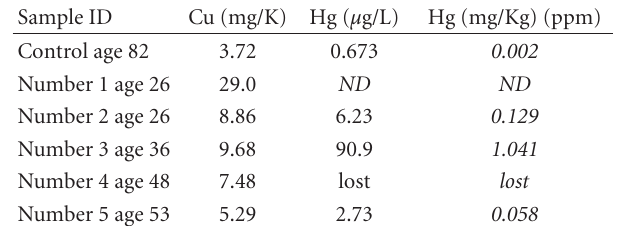
Table 1: Analyses of metals in hair from control and subjects in Huancavelica, Peru.